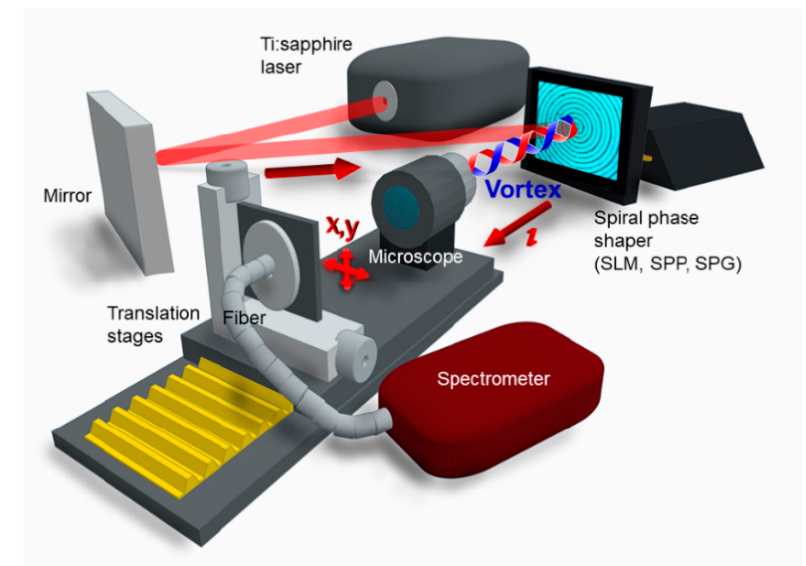
Figure 2. Experimental setup for the generation and detection of femtosecond vortex pulses. An orbital angular momentum is induced by optional use of a spatial light modulator (SLM), a transmissive diffractive spiral phase grating (SPG), or a reflective spiral phase plate (SPP) as beam shaper. The vortex is magnified by a microscope and analyzed in spectral domain by a scanning fiber-based spectrometer. The fiber is moved by high-precision xyz-translation stages. From detected local spectra, 2D maps of spectral statistical moments M (j) ( x , y ) are extracted for each distance z .